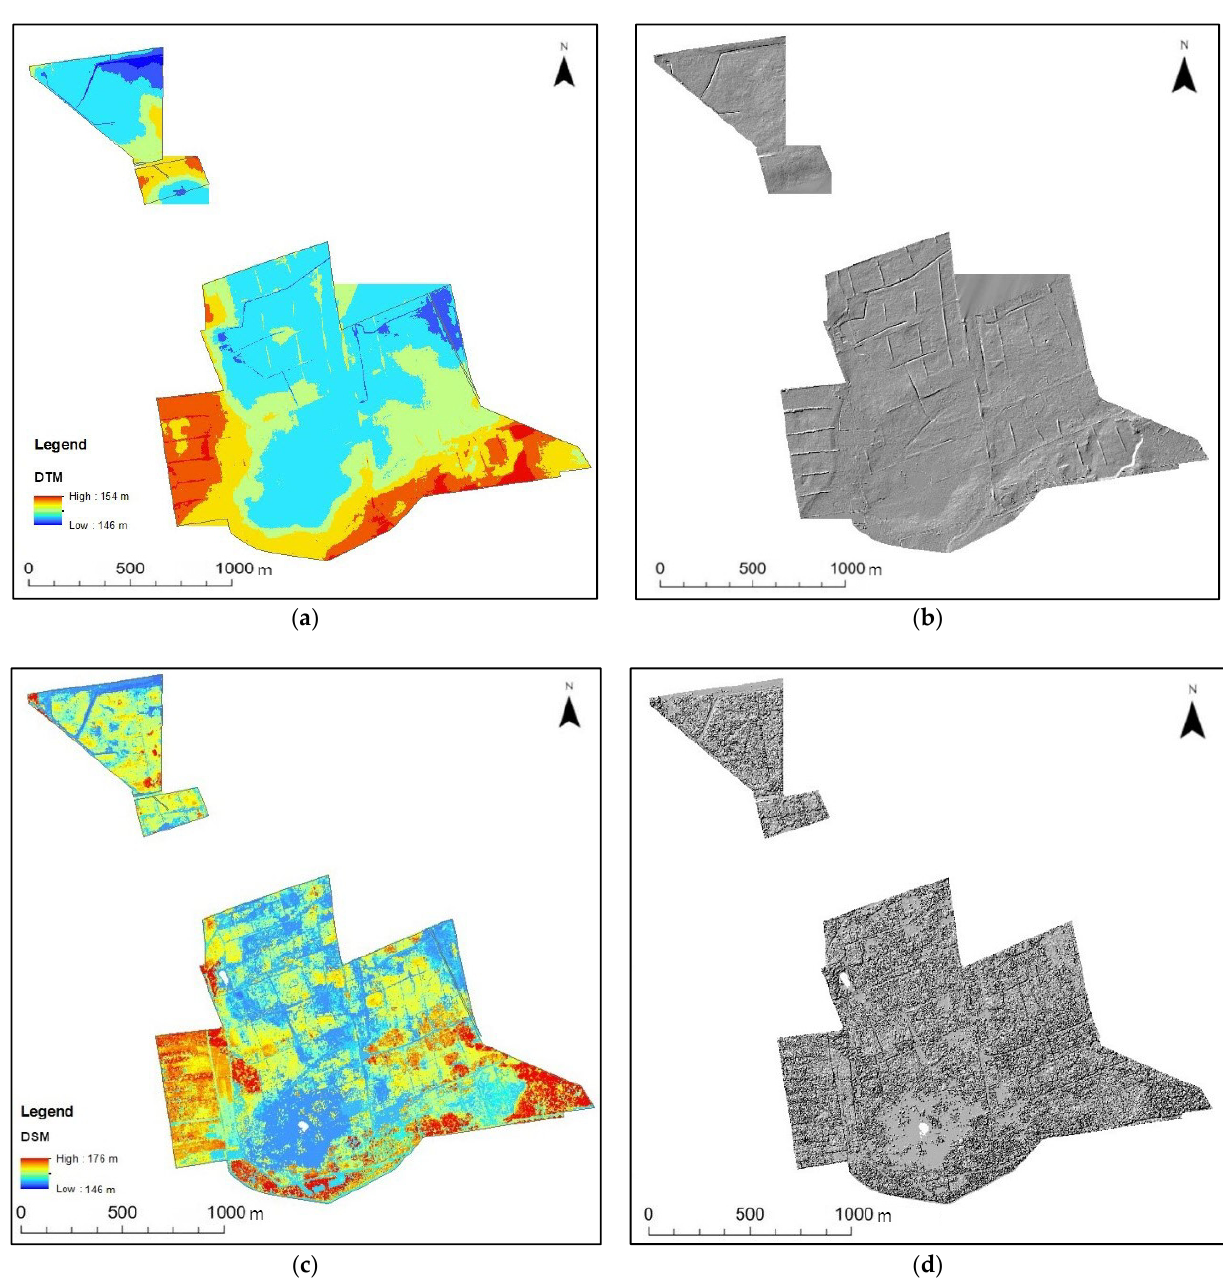
Figure 5. Jeziórko area: ( a ) digital terrain model (DTM) ; ( b ) DTM hillshade; ( c ) digital surface Figure 5. Jezi ó rko area: ( a ) digital terrain model (DTM); ( b ) DTM hillshade; ( c ) digital surface model (DSM); ( d ) DSM model (DSM); ( d ) DSM hillshade.